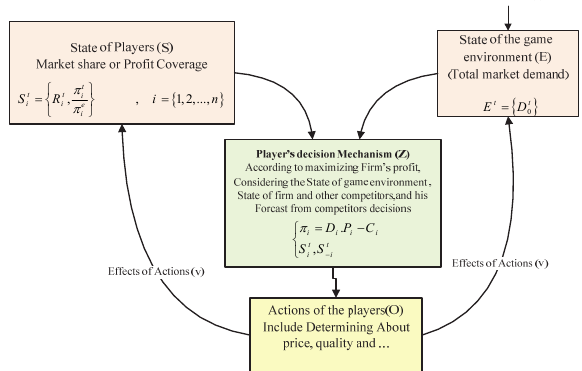
Fig. 2. The relationships between different